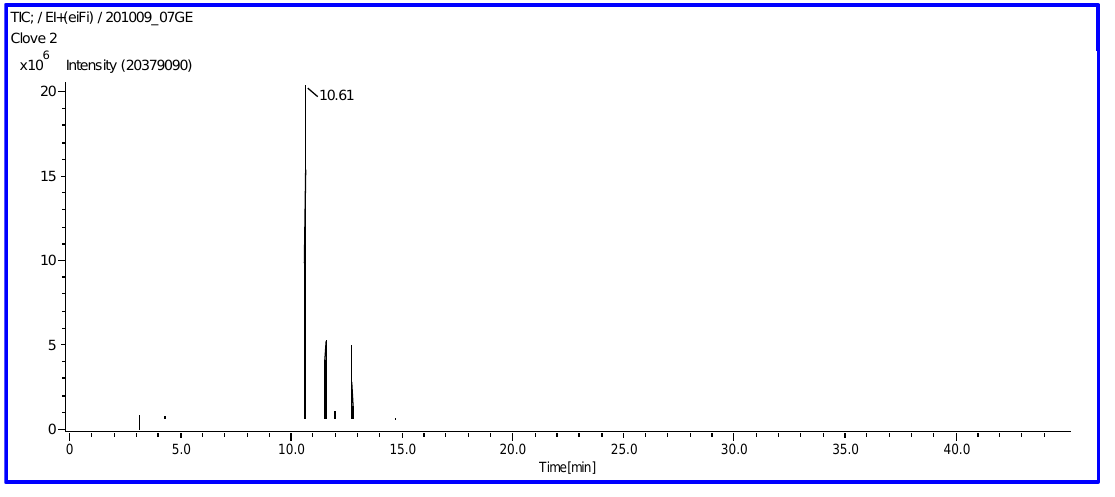
( B ) Rosemary extract Figure 1. GC-MS chromatogram of ethanolic clove ( A ) and rosemary ( B ) extracts. Table 2. The main chemical compositions of ethanolic plant extracts used in this study. Plant Extract